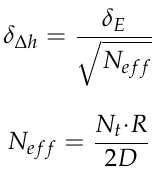
( a ) before and ( b ) after corrections for the period of 1975–2000.